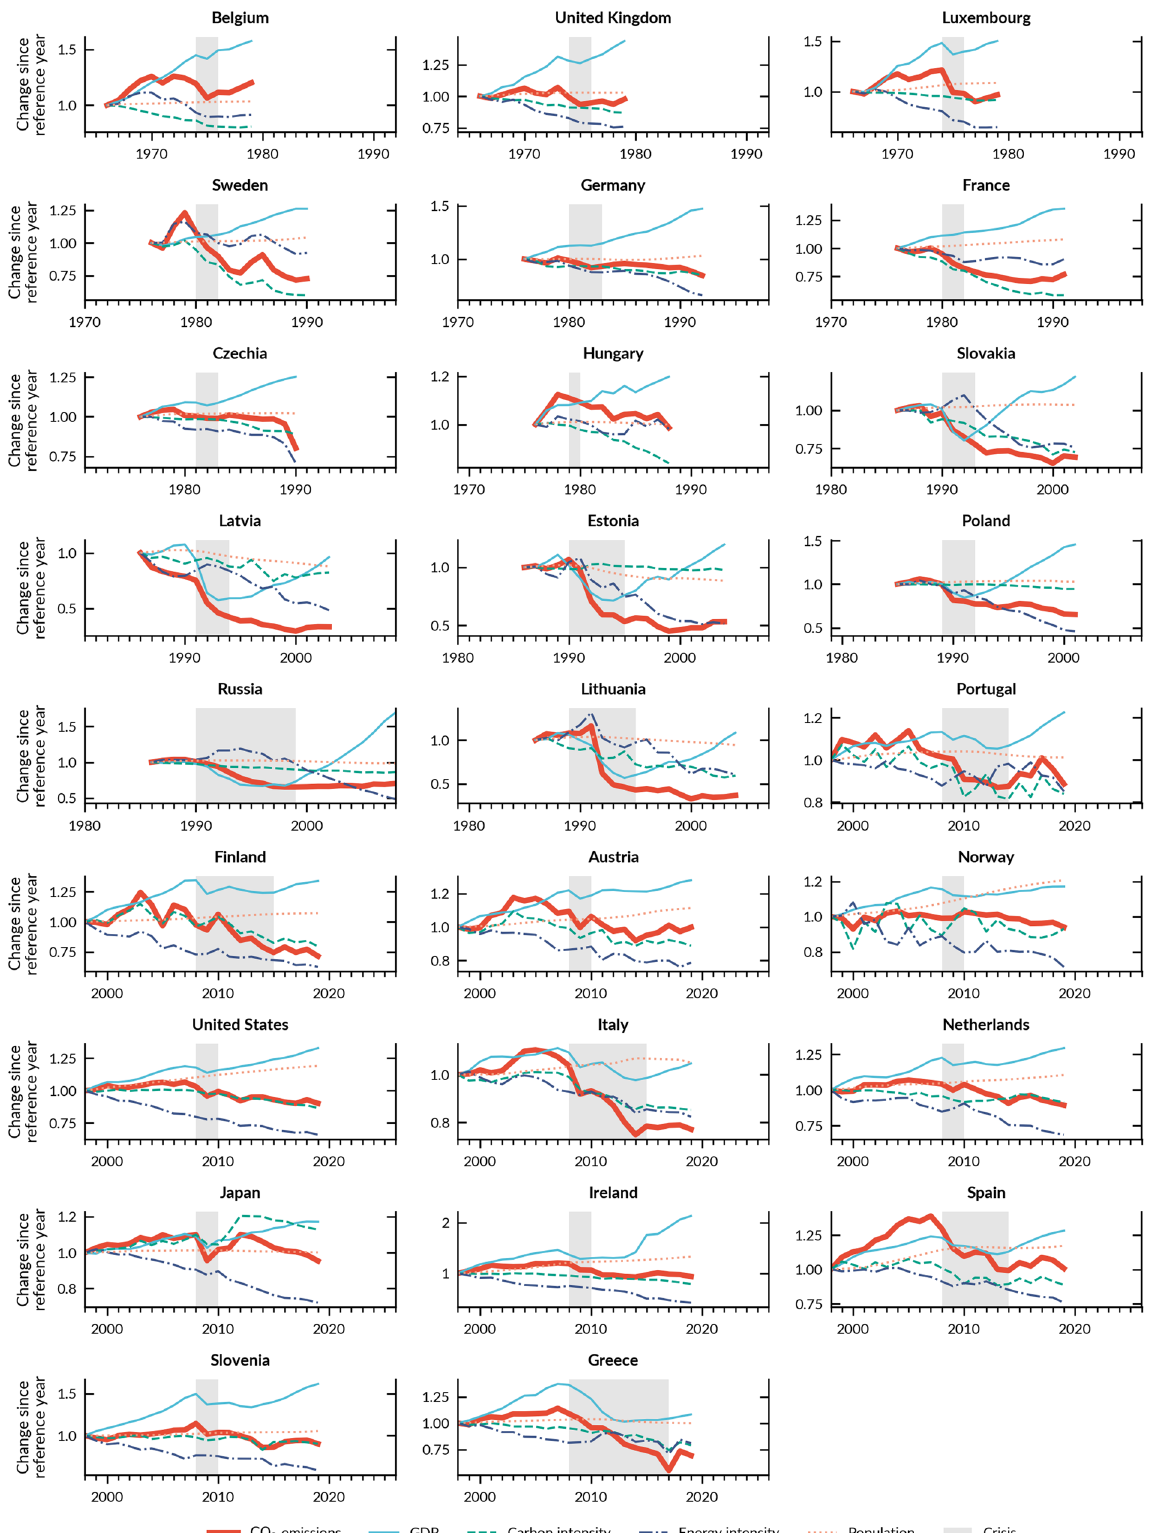
Fig. 4 Crises & CO 2 emission drivers. CO 2 emissions and cumulative decomposed emission drivers from the Kaya identity; 26 countries that peaked emissions around economic crises. Charts for all countries and years in Supplementary Note 6. Sources: 31,32,57 .